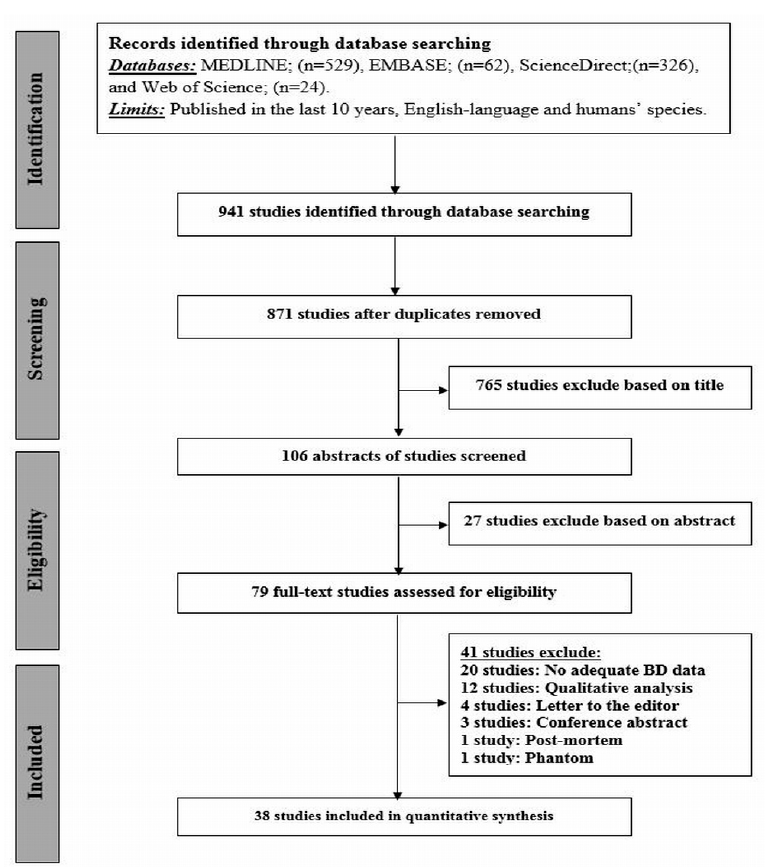
Figure 1. Preferred Reporting Items for Systematic Reviews and Meta-Analysis (PRISMA) flowchart of systematic review and meta-analysis of the excluded and included studies.